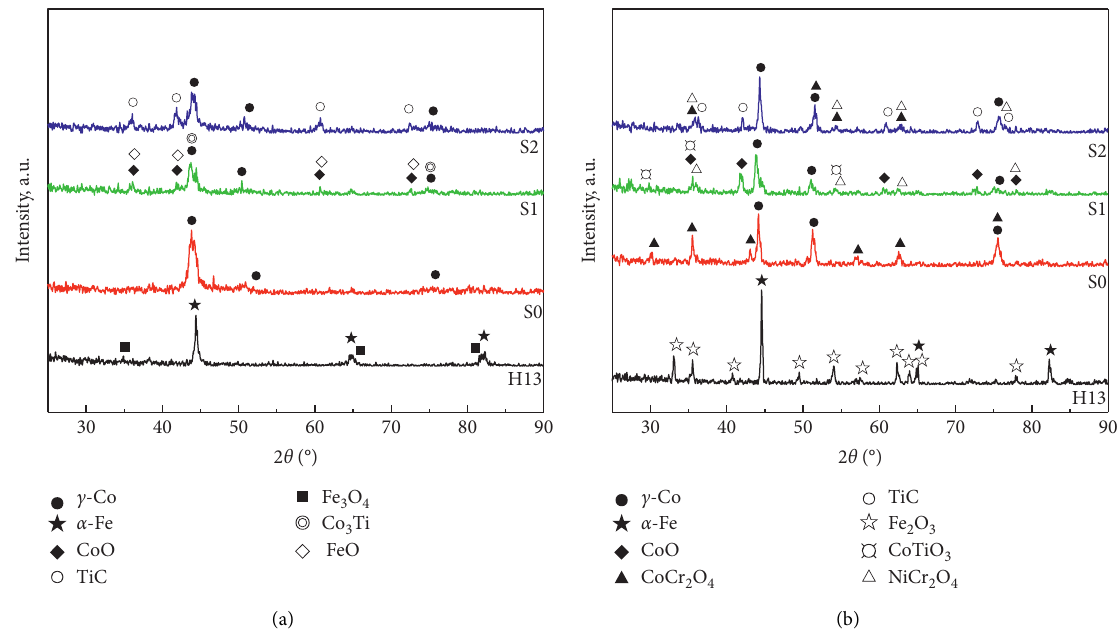
Figure 21: XRD patterns of H13 steel and S0, S1, and S2 coatings (a) at room temperature and (b) 700 ° C.